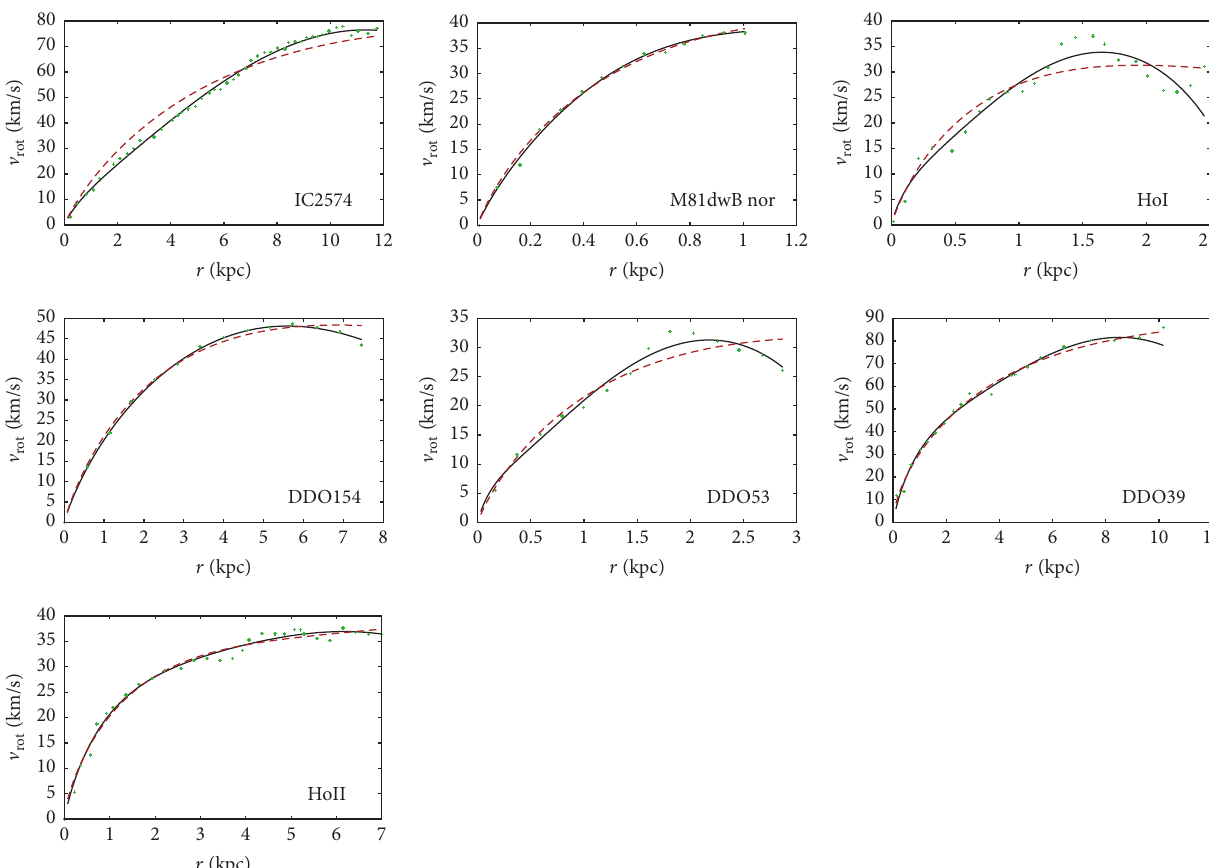
galaxy samples. For improved accuracy we also included realistic baryonic models in every case. For the HSB galaxy sample, both the rotation curve and the surface photometry data were available. Most of the rotation curves were smooth, symmetric, and uniform in